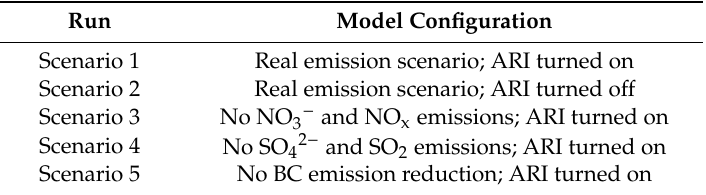
Figure 1. Model simulation domain and topography height (m). (BJ: Beijing; TJ: Tianjin; BD: Baoding; SJZ: Shijiazhuang; TS: Tangshan). Table 2. Configurations for the model sensitivity simulation.